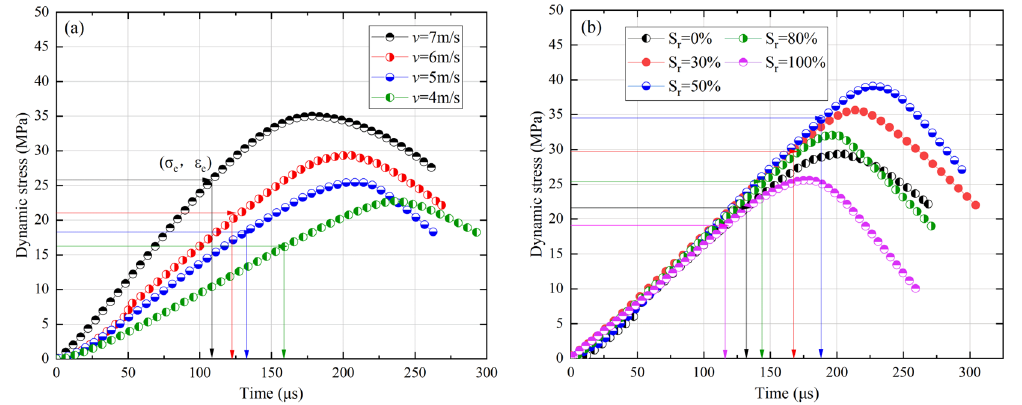
Figure 9. Dynamic stress versus time for frozen samples: ( a ) S r = 0%; ( b ) v= 6 m/s. Table 2. Dynamic mechanical parameters of sandstone under different conditions. Impact Samples Velocity